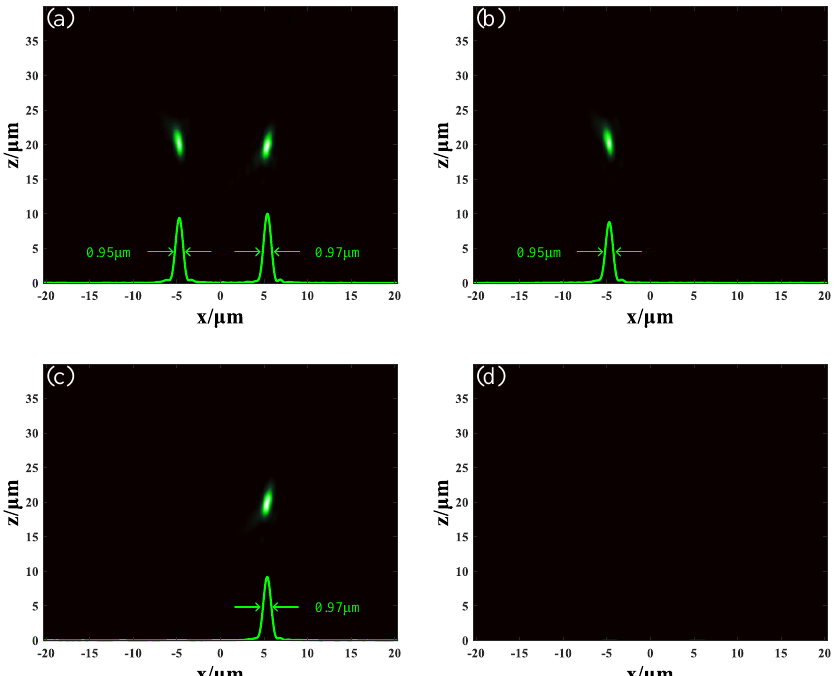
Figure 4. The light field distribution of metalens M 1 . ( a ) The GST in both sections are in amorphous state. ( b ) The GST in section A stays in amorphous state but the GST in section B stays in crystalline state. ( c ) The GST in section A stays in crystalline state but the GST in section B stays in amorphous state. ( d ) The GST in both sections are in crystalline state.